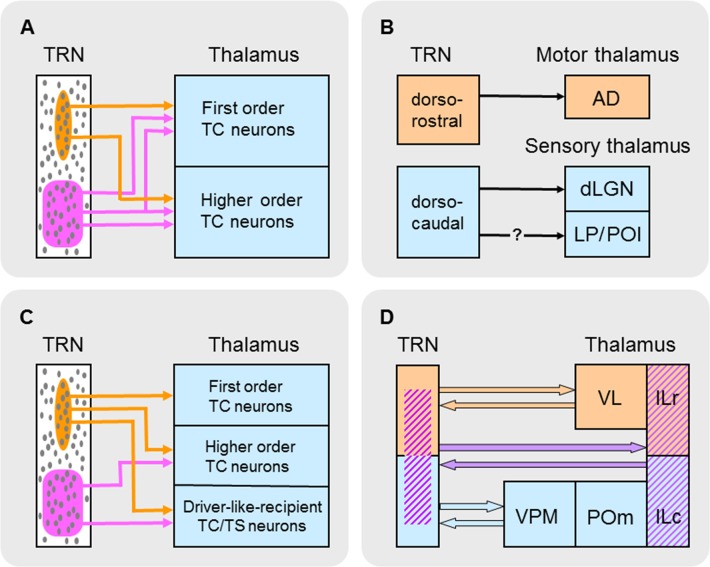
Schematic summary of different types of subnetworks in TRN. (A) TRN subnetworks identified according to their spatial distributions of electrically connected neurons through gap junctions (GJs) and connectivity with first order and/or higher order TC neurons. Elongated (circumscribed in orange) and broad (circumscribed in purple) GJ-related clusters of neurons (small gray ovals) are shown in TRN. (B) TRN subnetworks identified according to their state-dependent activity, location in TRN, and connectivity with first order thalamic nuclei. Neurons in dorsorostral TRN (orange) exhibit arousal-related activity whereas those in dorsocaudal TRN (blue) exhibit sleep-related activity. It is unclear whether this latter activity affects higher order sensory nuclei (LP and POl) in the thalamus. Abbreviations: AD, anterodorsal nucleus; dLGN, dorsal lateral geniculate nucleus; LP, lateral posterior nucleus; POl, posterior lateral nucleus. (C) TRN subnetworks identified according to their spatial distributions of neurons activated by glutamate corresponding to activation zones (AZs) and functional connectivity with first order and higher order TC neurons and driver-like-recipient thalamocortical/thalamostriatal (TC/TS) neurons. Elongated (circumscribed in orange) and broad (circumscribed in purple) AZ-related clusters of neurons (small gray ovals) are shown in TRN. (D) TRN subnetworks identified according to their mediation of interactions between groups of thalamic nuclei. Each group of interacting nuclei in the thalamus (shown on the right) is color coded. A possible distribution of neurons that mediate these interactions in TRN (shown on the left) is similarly color coded. Abbreviations: ILc, caudal intralaminar nuclei; ILr, rostral intralaminar nuclei; POm, posterior medial nucleus; TRN, thalamic reticular nucleus; VL, ventrolateral nucleus; VPM, ventroposterior medial nucleus.